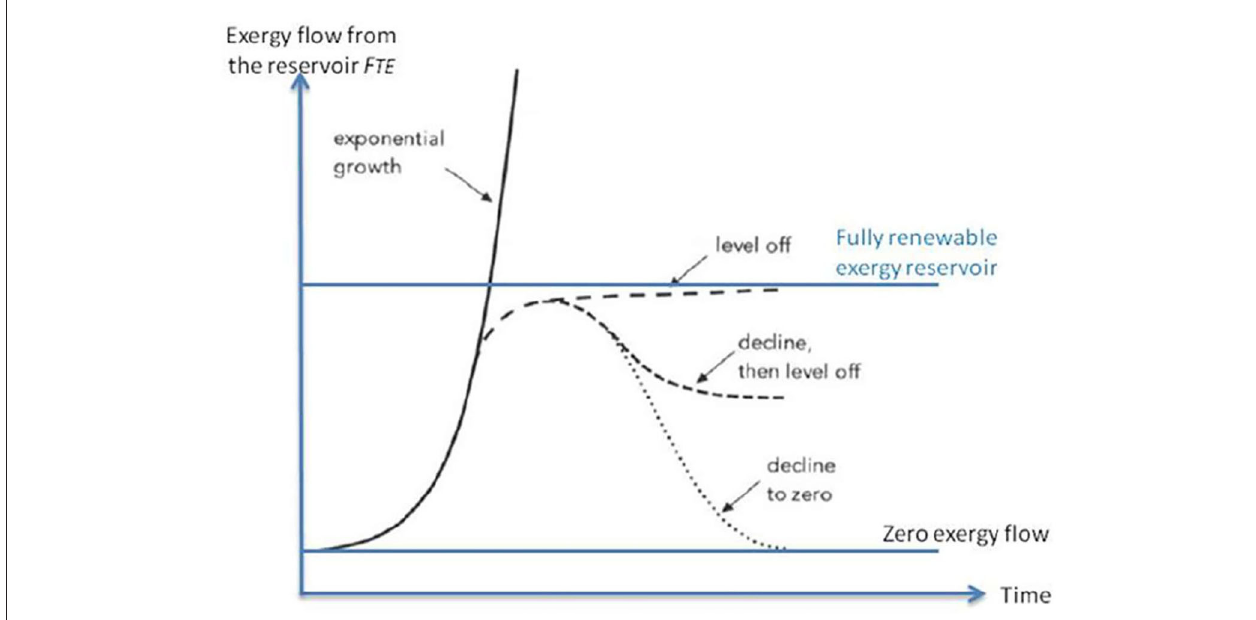
FIGURE 3 | Different kind of behavior for the exploitation of resources from the